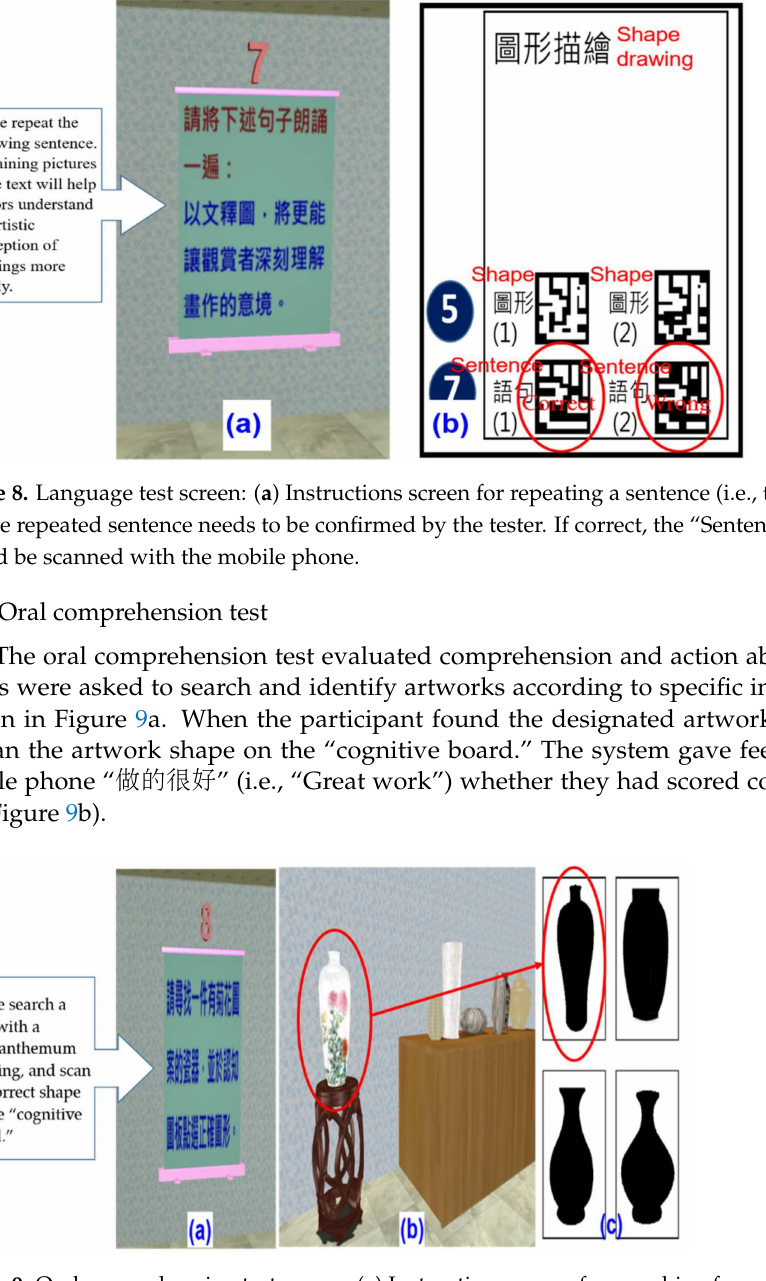
Figure 9. Oral comprehension test screen: ( a ) Instructions screen for searching for a specific artwork (e.g., lacquerware with chrysanthemum drawing); ( b ) The target; ( c ) Confirm and scan the correct shape on the “cognitive